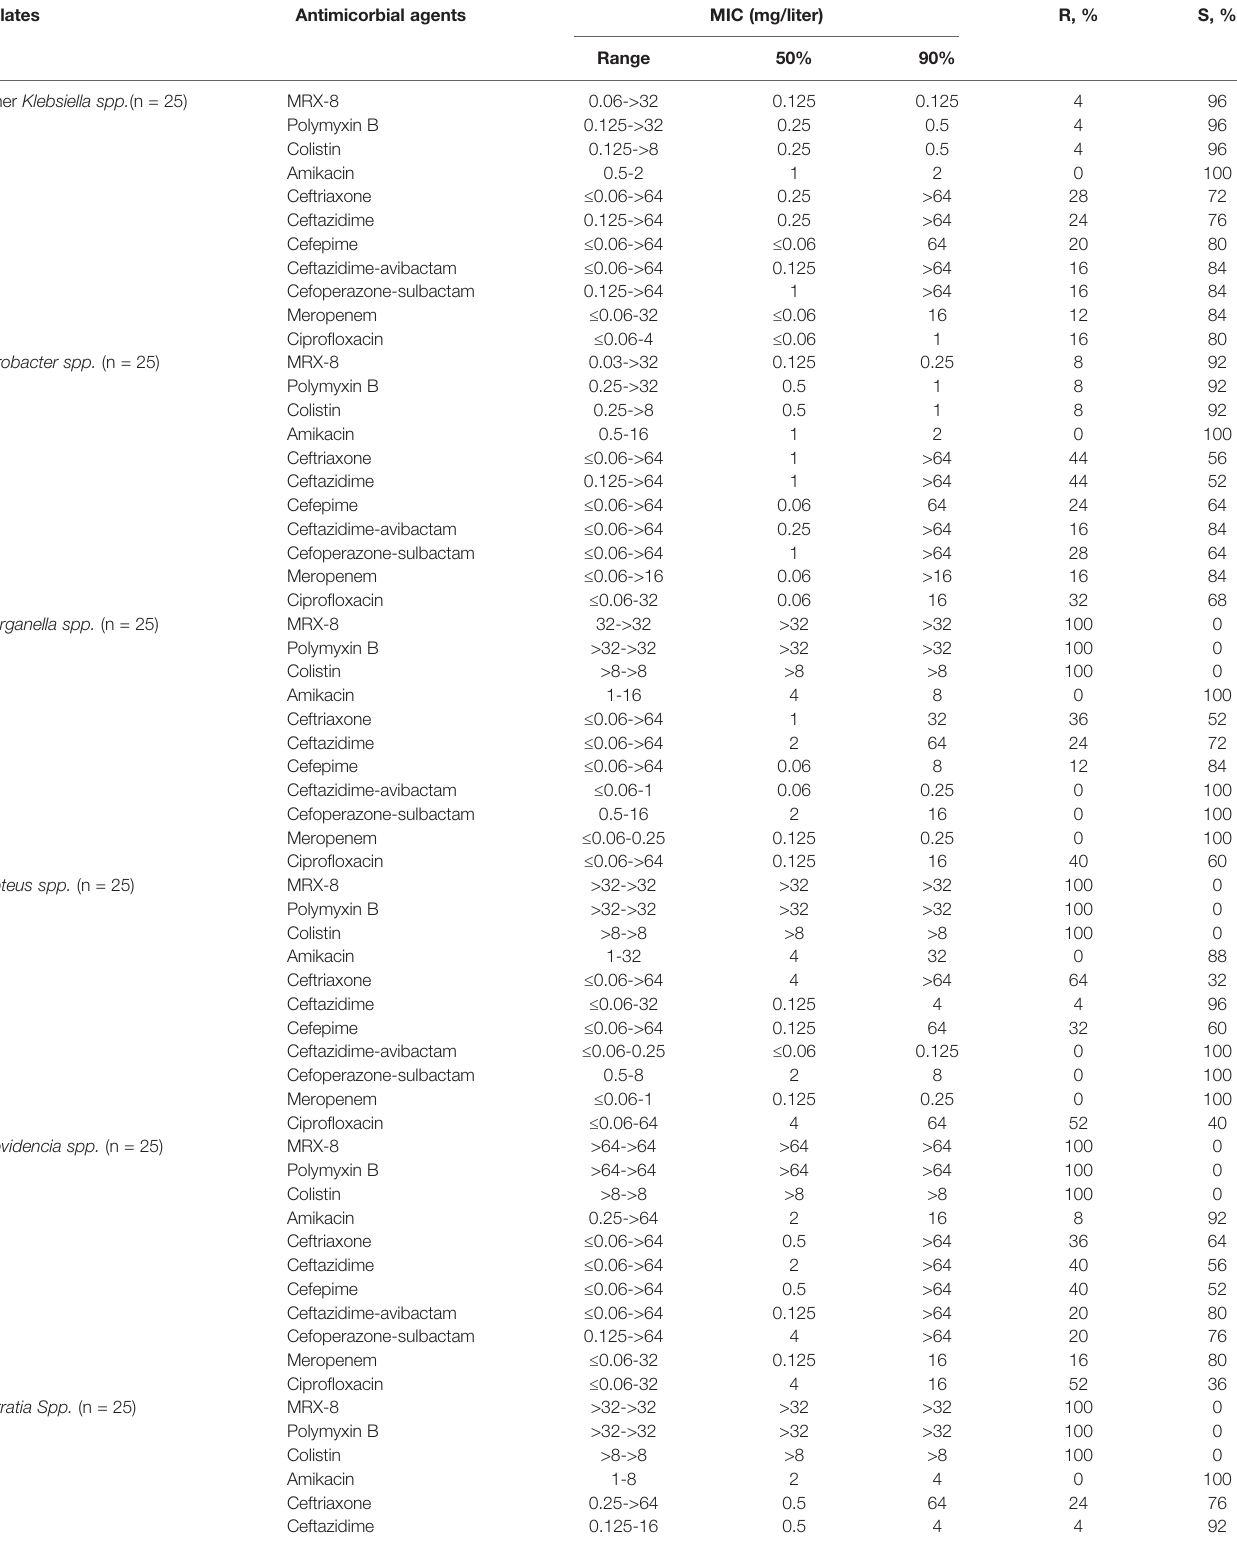
TABLE 3 | In vitro activity of MRX-8 and other comparator agents against 187 of other Enterobacterales (mg/L). Isolates Antimicorbial agents MIC (mg/liter) R, % S, % Range 50% Other Klebsiella spp. (n =